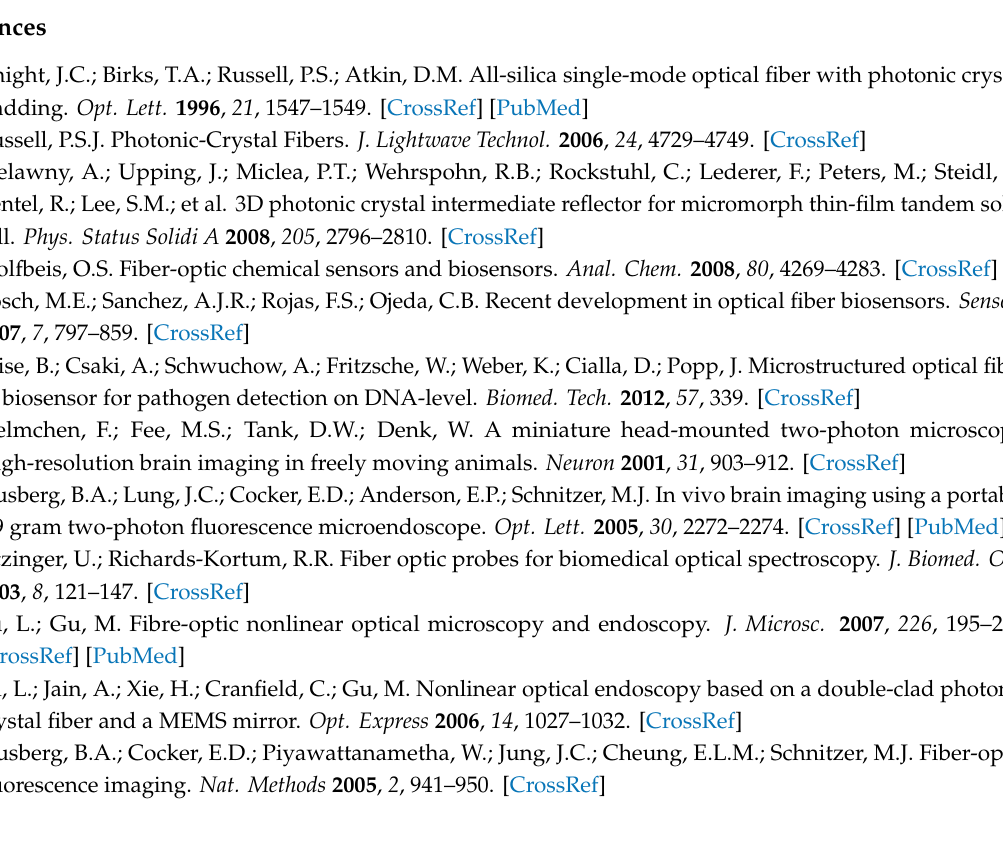
Figure A1. Transmission spectra for MOWs coated with the buffer layer only: measured (black) and smoothed (red). Transmission spectra for MOWs coated with one layer of 300-nm silica particles: measured (green) and smoothed (blue).